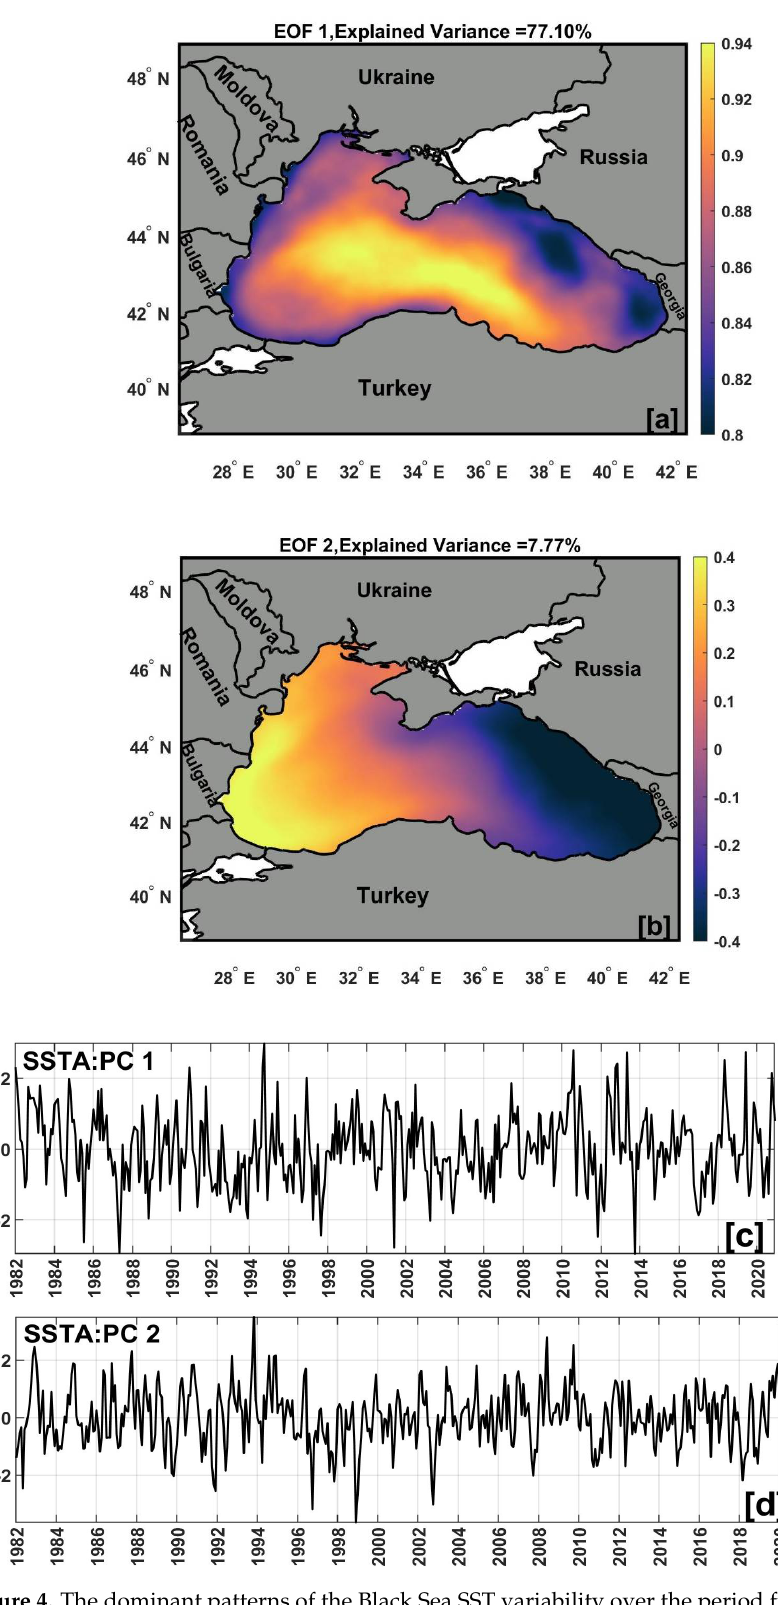
Figure 4. The dominant patterns of the Black Sea SST variability over the period from 1982 to 2020. ( a ) The spatial principal mode (EOF1) and ( c ) its corresponding temporal evolution (PC1). ( b ) The spatial second mode (EOF2) and ( d ) its corresponding temporal evolution (PC2). Temporal evolution for (PC1-2) in normalized variance units.